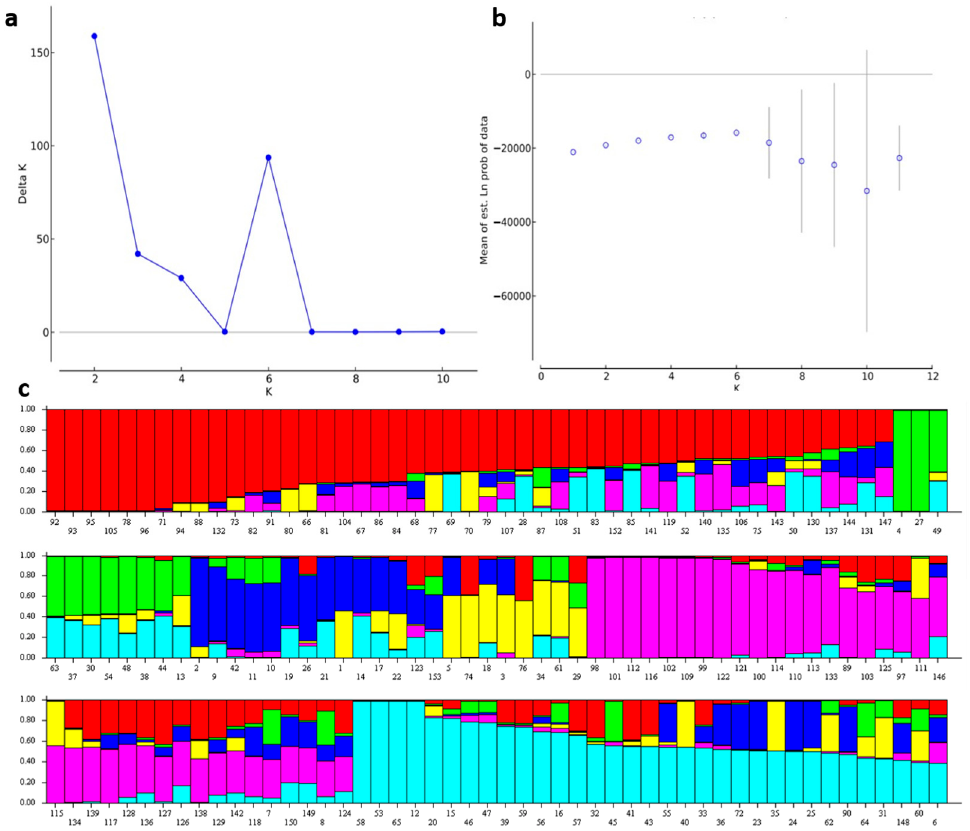
Figure 2. Genetic structure of the 155 soybean lines evaluated with 186 SNP markers. ( a ) The number of subpopulations identified by the LnP(D) and K model with an elevated Δ K value calculated for K varying up to K = 2 to 10; ( b ) mean of est. Ln prob data. ( c ) Population structure analysis of the 155 lines accomplished from K = 6. Note: In ( c ), each individual represents a vertical line divided into K colored segments, with length proportional to the individual coefficient of participation in the K clusters for each cluster and are described at Supplementary Table S3.